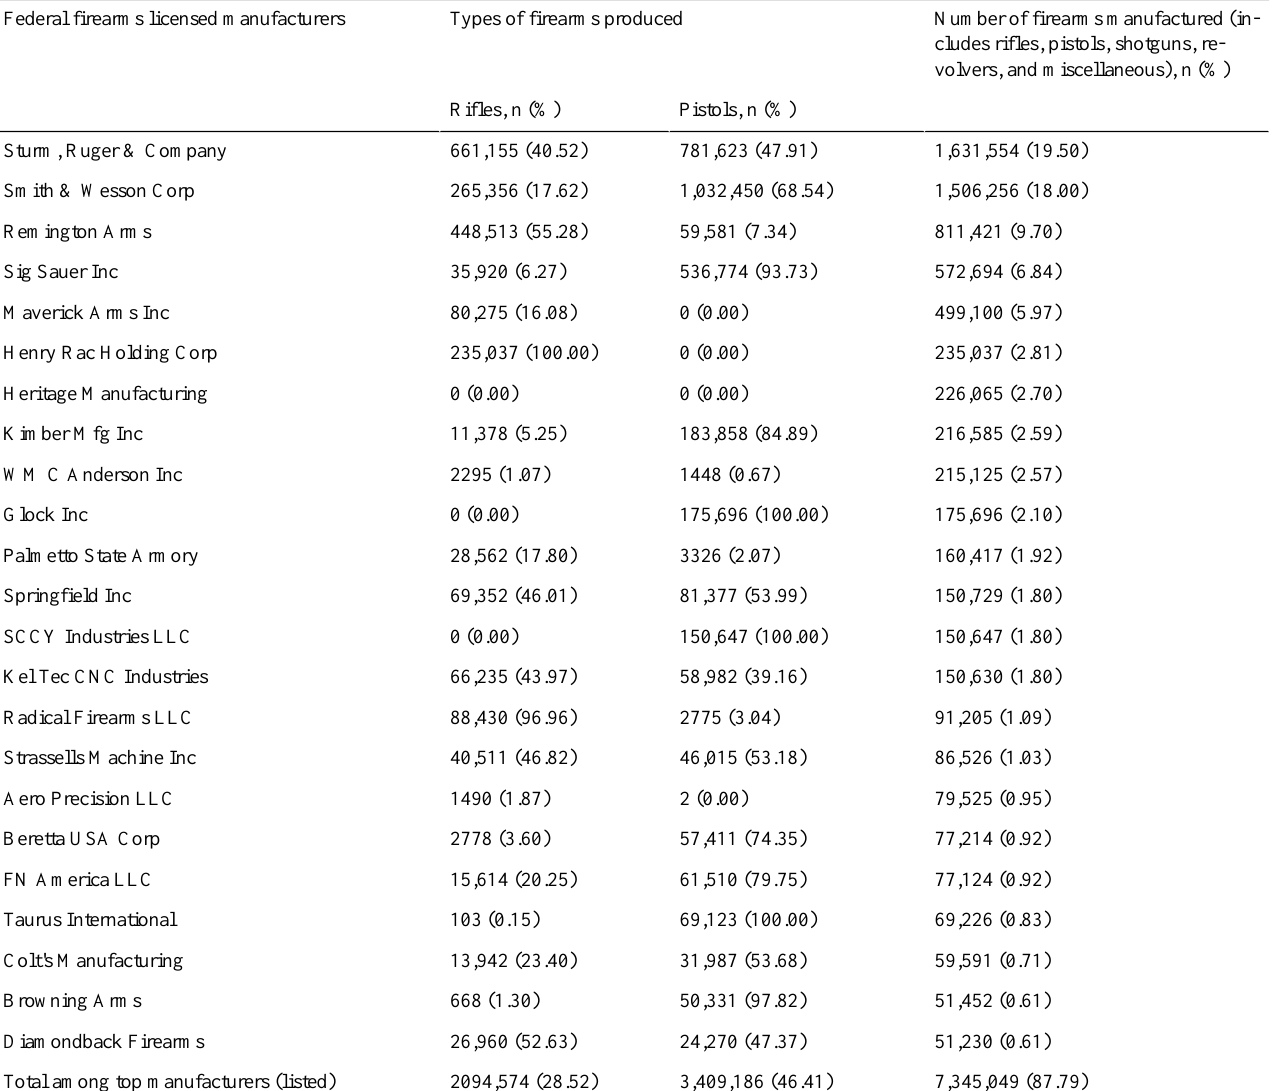
Table 1. Firearm manufacturing characteristics of top domestic producers (over 50,000 firearms produced in 2017).